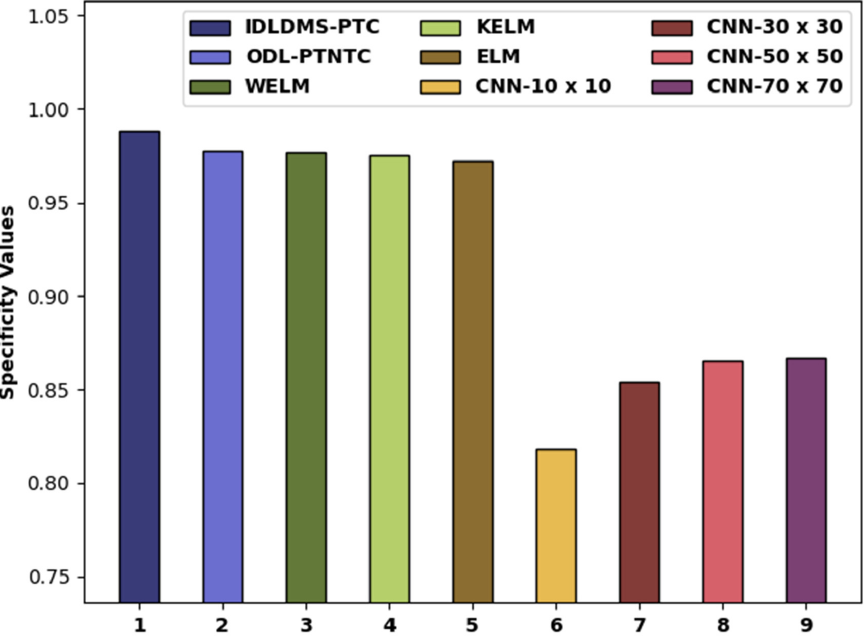
Figure 10. Spec y analysis of IDLDMS-PTC technique compared with recent Figure 10.   analysis of IDLDMS-PTC technique compared with recent approaches.